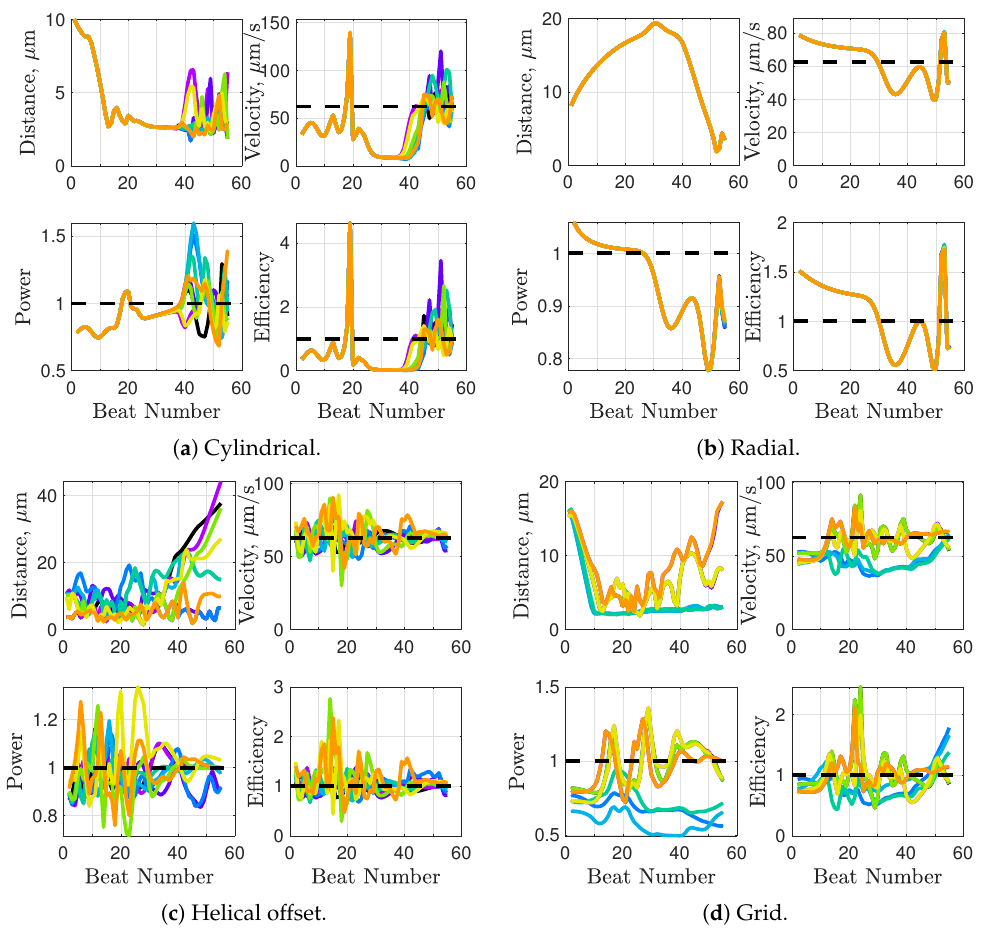
Figure 10. Comparison of minimal distances to neighboring flagella (upper left plot in each panel), velocities (average path velocities), power, and efficiency in reference to an individual swimmer in free space (dotted line). Note that power and efficiency have been normalized in reference to an individual swimmer in free space. Colors of curves correspond to the flagellum of the same color from the initial configurations in Figure 4.